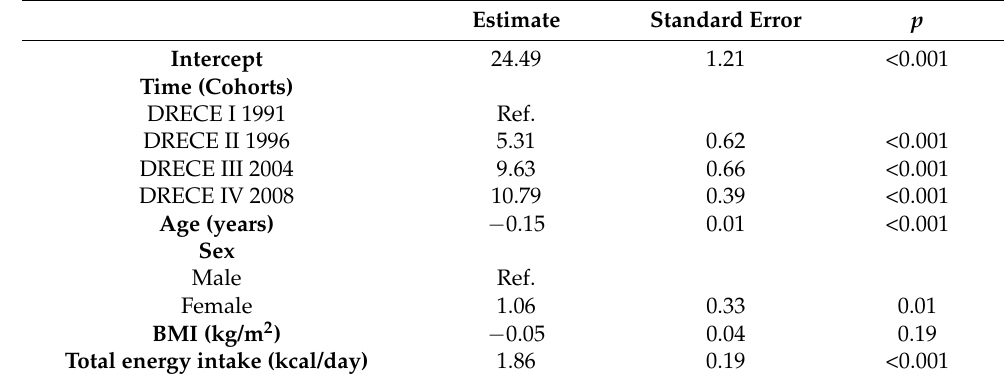
Table 2. Mixed model coefficients for UPF consumption over time adjusted for age, sex, BMI, and total energy